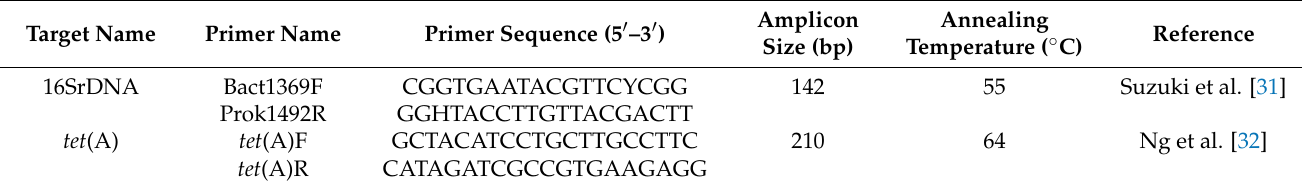
Table 1. Primers pairs used to detect and/or quantify 16S rDNA and antibiotic-resistance